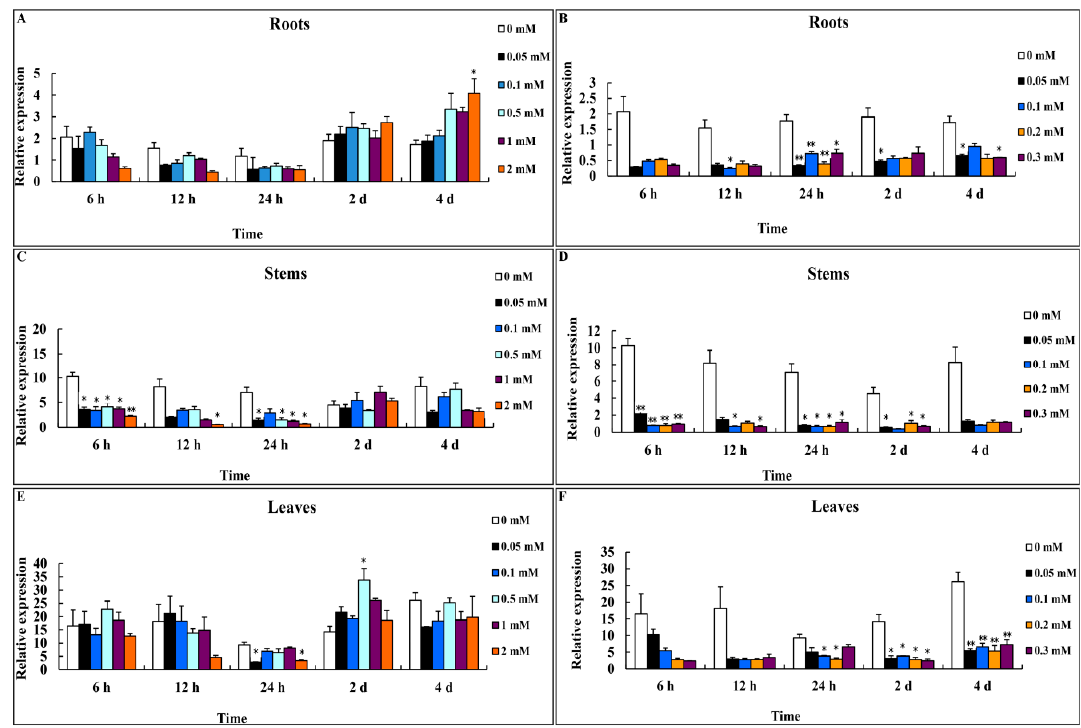
Figure 2. Expression profiles of CsMTL2 in the roots, stems, and leaves of cucumber grown under Zn 2+ and Cd 2+ stress. CsMTL2 expression in the roots, steams, and leaves of cucumber plants grown in the presence of different concentrations of Zn 2+ ( A , C , E ) and Cd 2+ ( B , D , F ) for the indicated periods, as detected by quantitative reverse transcription ‐ polymerase chain reaction (qRT ‐ PCR). Values represent the mean ± standard deviation (SD) of three biological replicates, with three technical replicates for each organ. Statistical significance was based on Student’s t ‐ test * : p < 0.05; ** : p < 0.01.